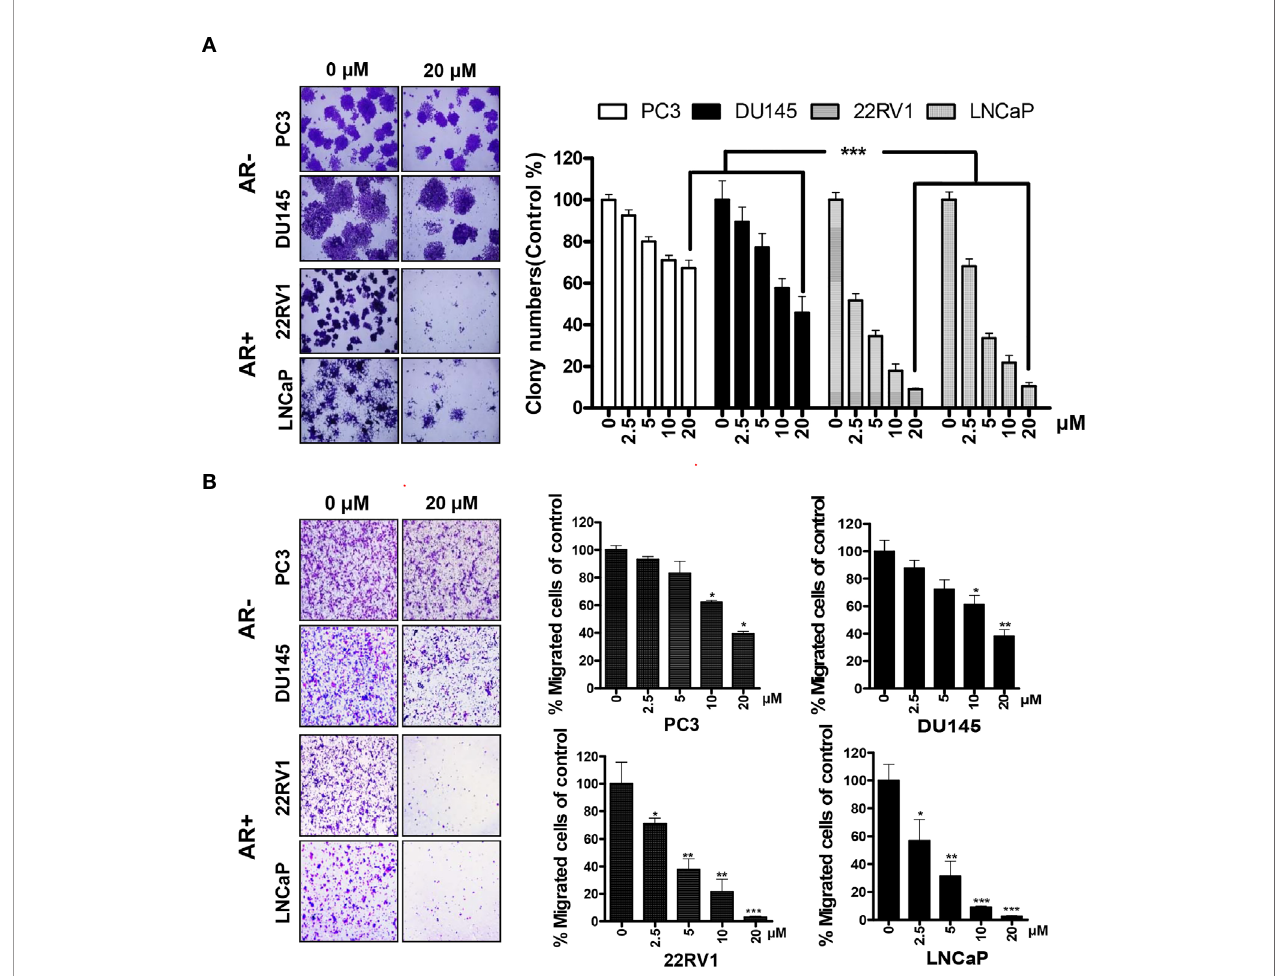
FIGURE 2 | AR-positive PCa cells were more sensitive to HG122. (A) AR-negative cell lines PC3 and DU145 and AR-positive cell lines LNCaP and 22RV1 were treated with 0 or 20 µM HG122 in 6-well plates. After 7 days, cell colonies were counted, and colony formation for each cell line was presented (n = 3). (B) HG122 inhibited AR-positive cell line LNCaP and 22RV1 migration more effectively. A total of 1 × 104 PCa cells were seeded in the top chamber and treated with different concentrations of HG122, while 10 nM DHT was added in the bottom chamber. After 12 h, the cells that migrated were stained and quanti fi ed. Each bar in the histogram represents means ± SD of three independent experiments, *, P < 0.05; **, P < 0.01; ***, P < 0.001, compared to the vehicle control